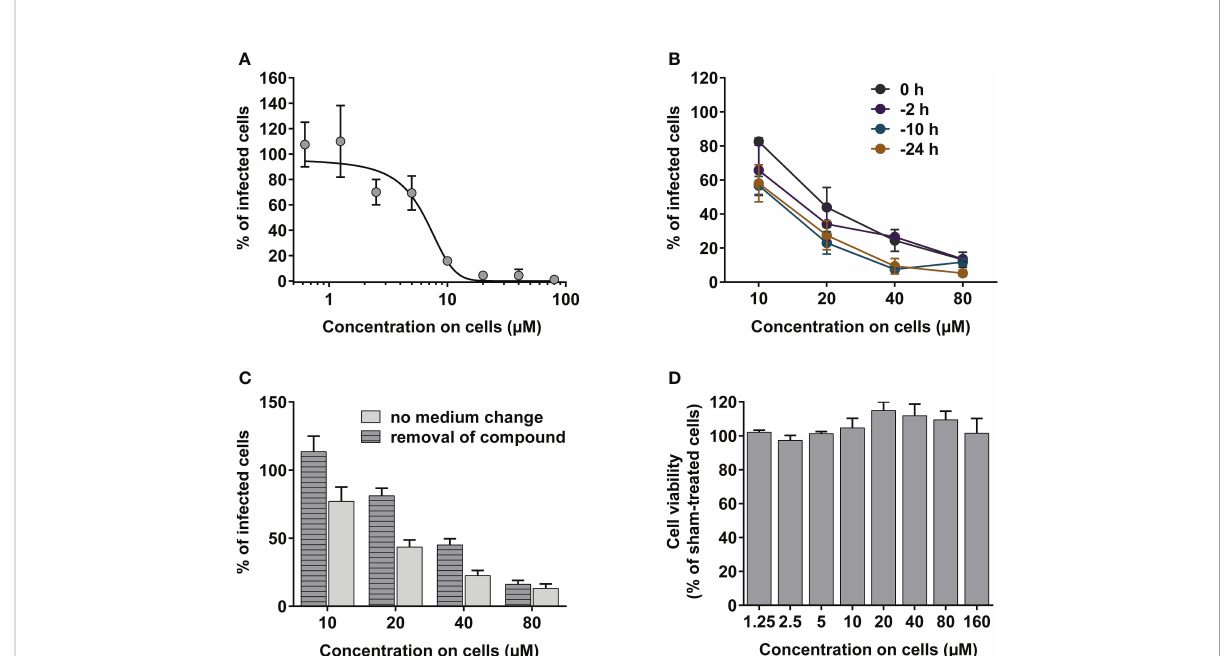
FIGURE 4 Evaluation of in vitro antiviral activity of peptide candidate Pep30. (A) In vitro dose-response curve of Pep30. Peptide was mixed with 150 FFU of rgRSV at indicated concentrations and incubated for 10 min at 37°C before applying on HEp-2 cell monolayers. (B) In vitro antiviral activity of Pep30 in prophylactic assay. Pep30 was applied on HEp-2 cell monolayers in concentrations of 10-80 µM at indicated time points before infection with 150 FFU of rgRSV/well. (C) In vitro antiviral activity of Pep30 in cell pretreatment assay. Pep30 was applied on HEp-2 cells at indicated concentrations for 30 min and the medium was either removed or left on cells before inoculation of 150 FFU of rgRSV/well. GFP- positive infected cells in A, B and C were quanti fi ed at 2 dpi using fl uorescence EliSpot reader and normalized to infected and vehicle-treated controls. Shown are mean values of two independent experiments, each in triplicates ± SD. (D) Analysis of the cytotoxic effects of Pep30 in indicated concentrations on HEp-2 at 48 h post-treatment using ATP-based cell viability assay. Shown are mean values of two independent experiments, each in triplicates normalized to vehicle-treated controls ±